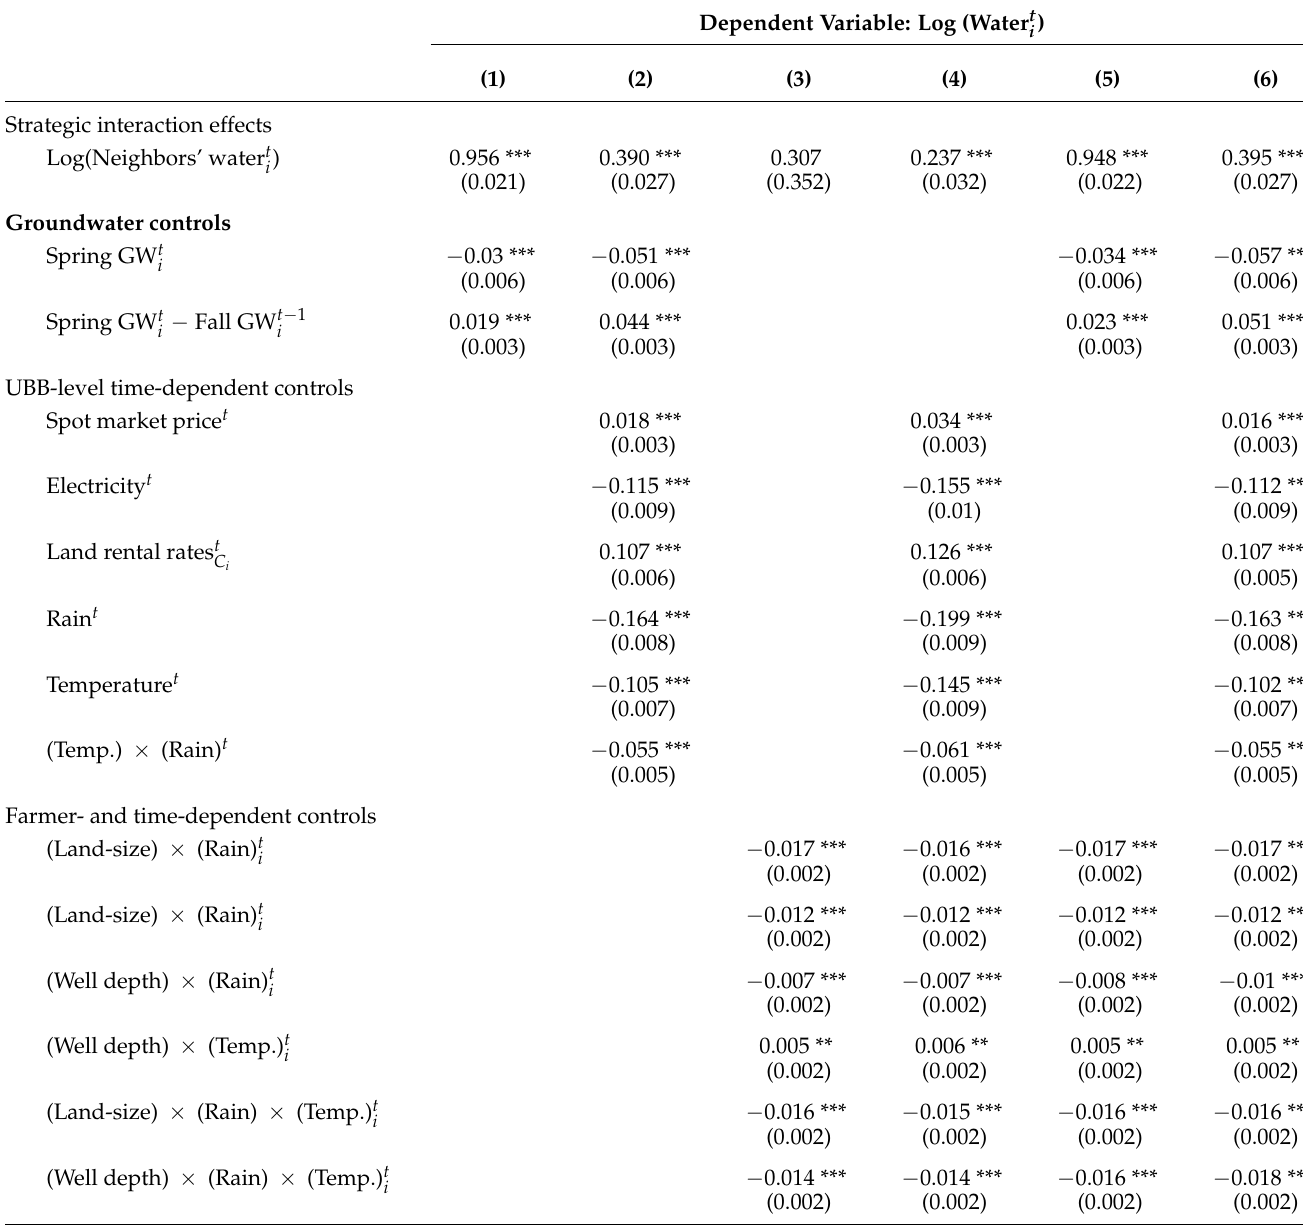
Table 2. Micro-level regressions on UBB data. Number of observations = 97,160. Number of randomly sampled regressions = 10,000. Regressions are combined using the Rubin’s rule [98], and p -values are calculatd using the Barnard-Rubin corrected degrees of freedom